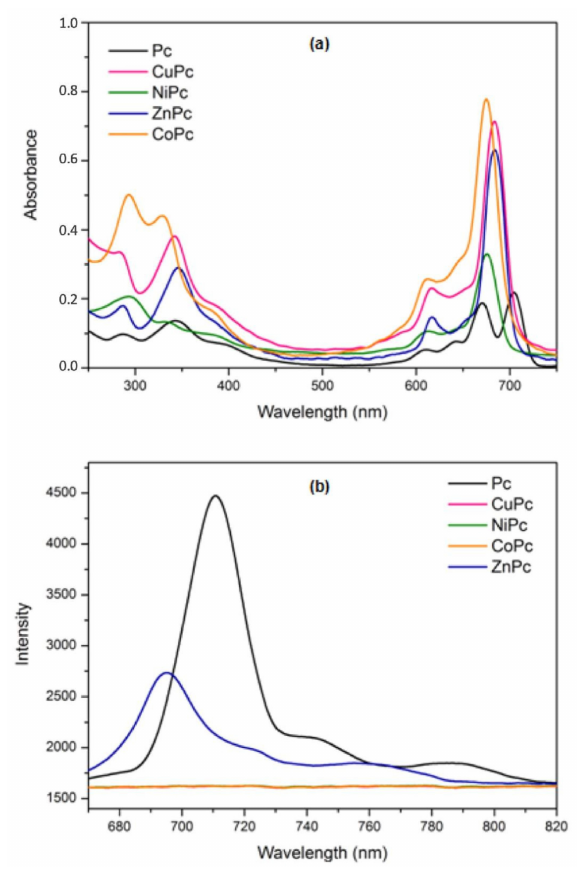
Figure 6. Absorption spectra ( a ) and emission spectra ( b ) of